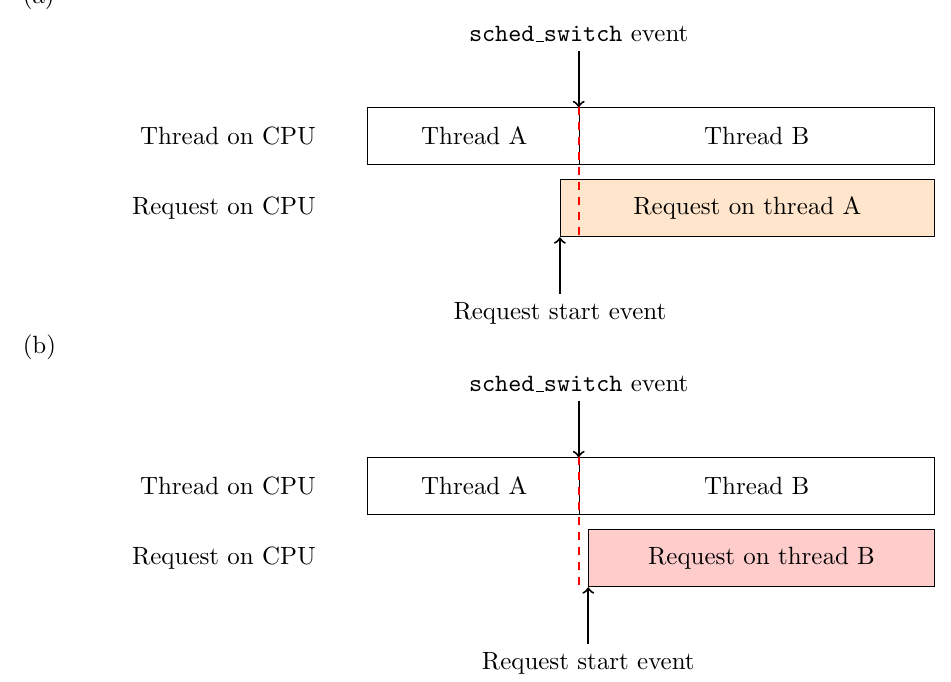
Figure 3. Impact of the precision of timestamps on trace analysis. The role of an event-driven analysis is to reconstruct the state of a machine at any given time using the sole trace events. Different event sequencing can yield different analysis results. In our case, insufficient precision on the distributed tracing events can impact the analysis depending on whether the request starts ( a ) right before or ( b ) right after a scheduling